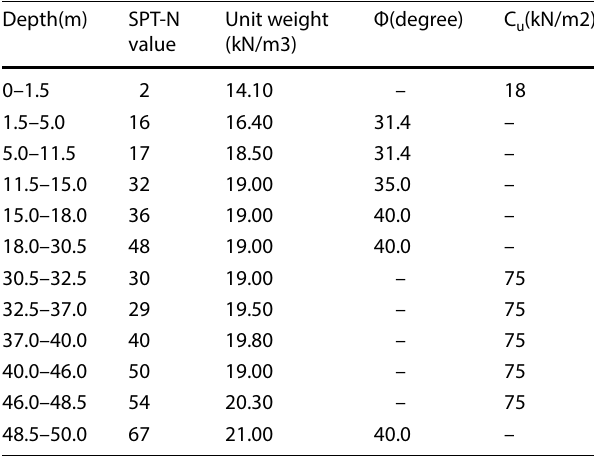
Table 3 Typical soil properties of RCD soil of Tollygunge Metro site (after Roy et al. 2018